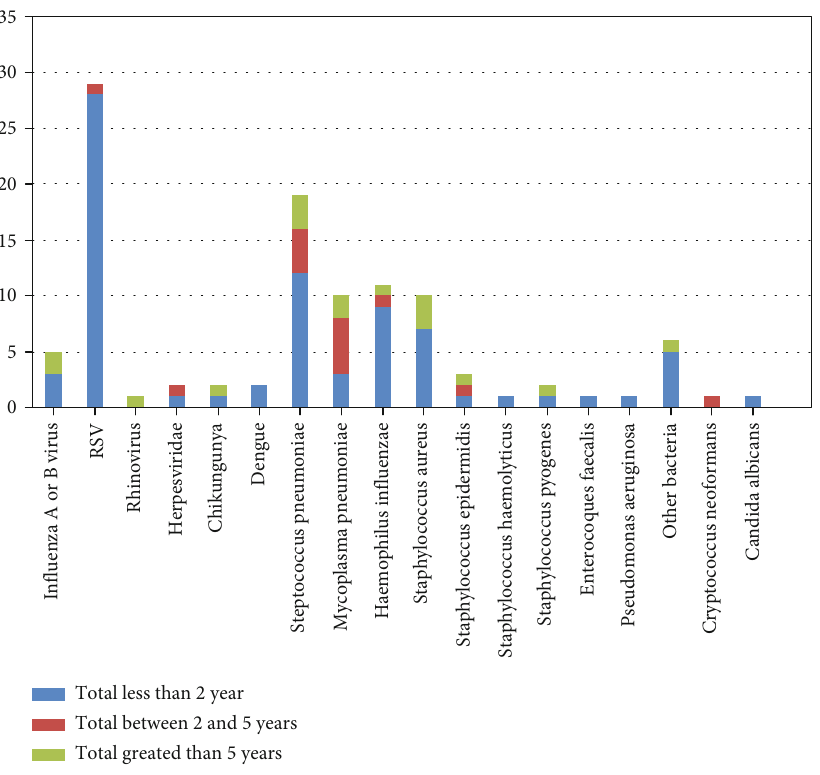
Figure 5: Distribution of pathogens according to